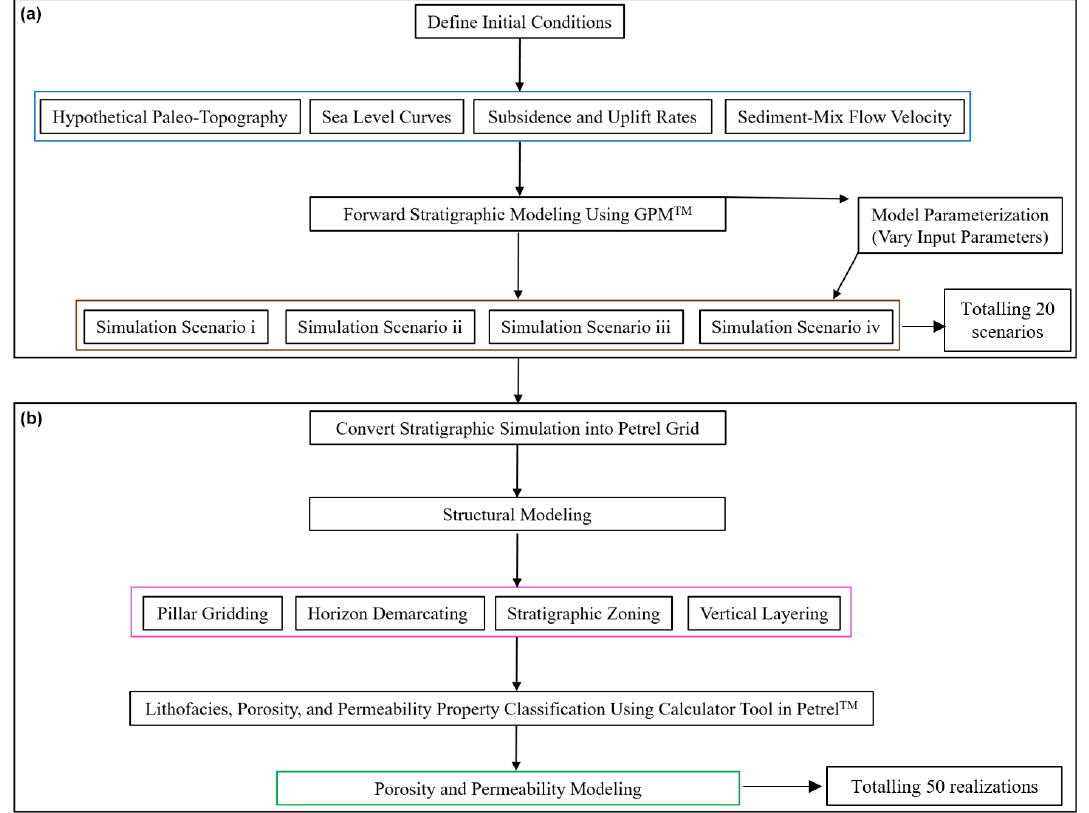
Figure 2. Schematic workflow of processes involved in this work. (a) Information of boundary conditions (input parameters) used for the forward stratigraphic simulation in GPM™; (b) illustration of the use of forward stratigraphic models in Petrel™ for porosity and permeability